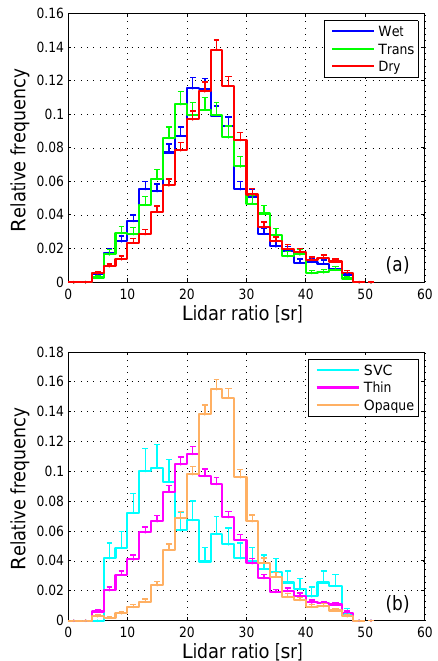
Figure 8. Normalized histograms of the lidar ratio, already cor- rected for multiple scattering, for the different seasons (a) and for SVC, thin, and opaque cirrus (b) are shown. Error bars indicate the counting statistics